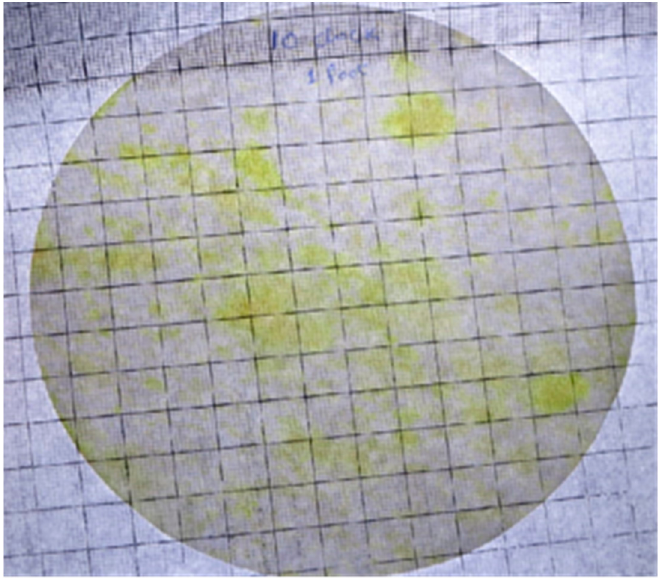
Figure 4. Filter paper disc with a transparent grid to count the contamination area.